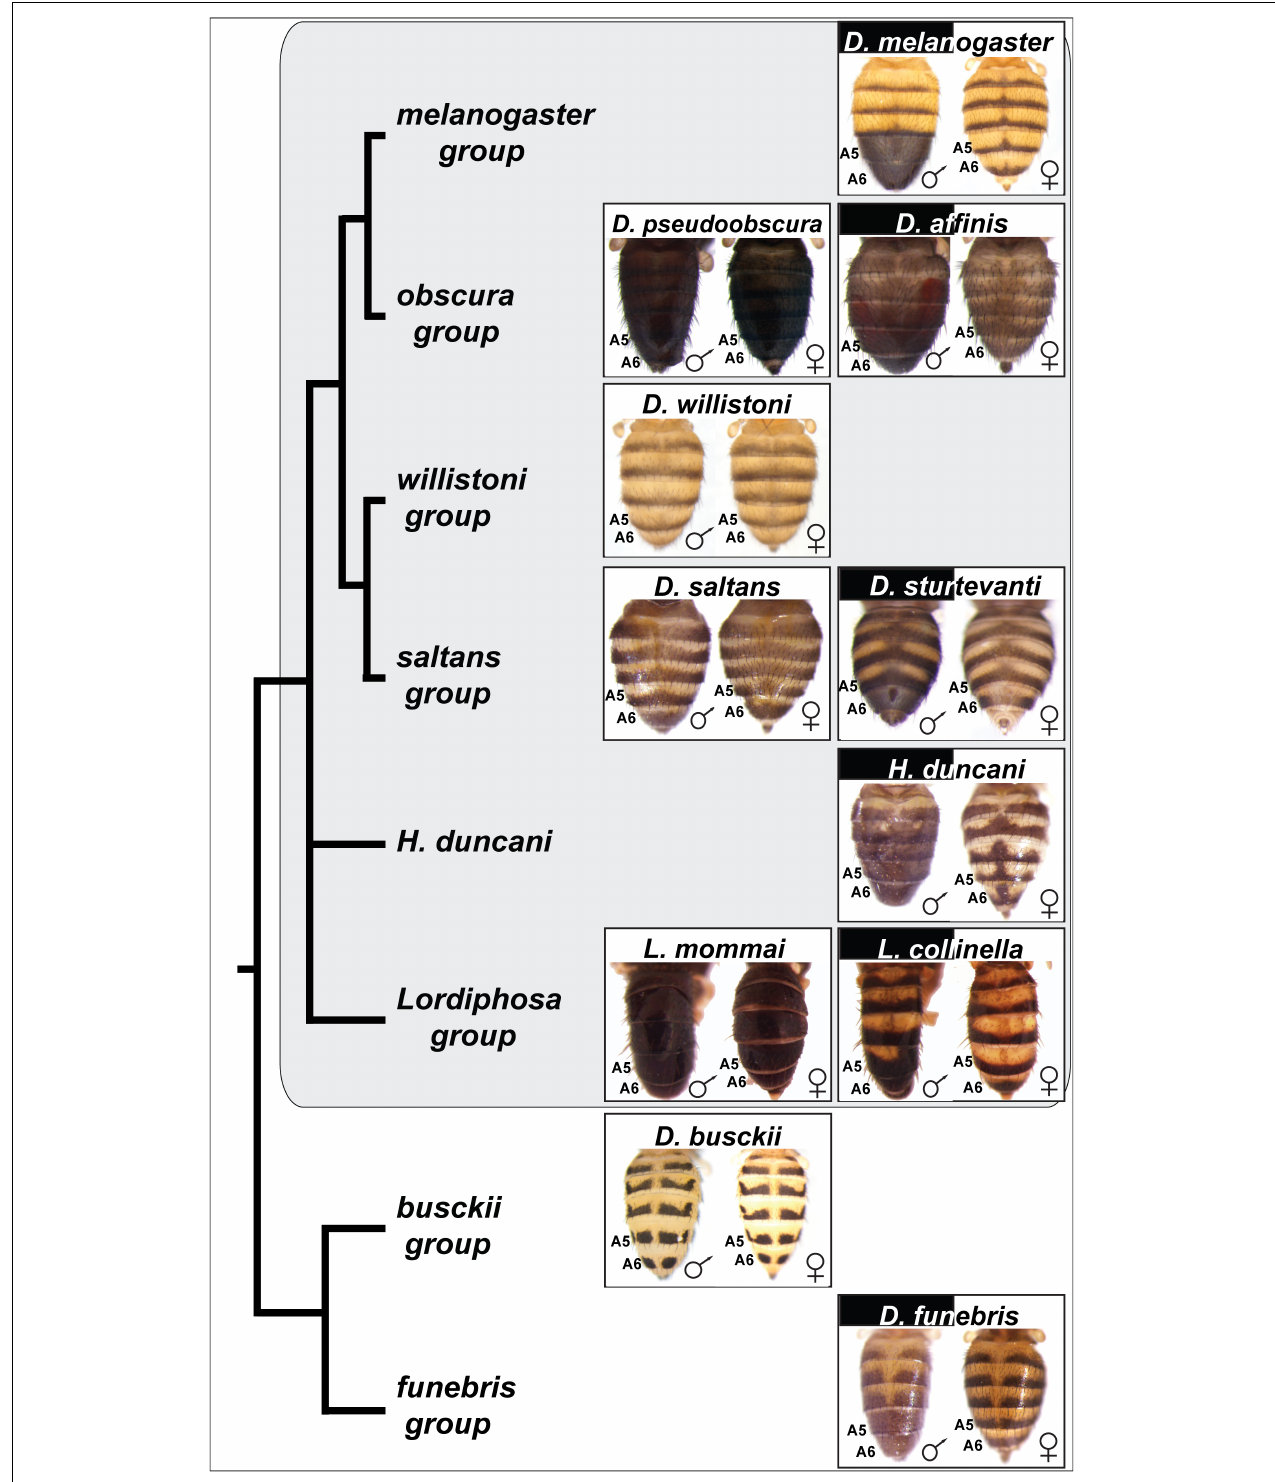
FIGURE 2 | Species with dimorphic tergite pigmentation are widespread throughout the Drosophila genus. Sophophora subgenus species groups and species are indicated by the gray background. D. busckii and D. funebris are included as non- Sophophora species from the Drosophila genus that respectively exhibit monomorphic and dimorphic patterns of tergite pigmentation. The homologous A5 and A6 segment tergites are indicated for each species, the segments bearing the dimorphic pigmentation in D. melanogaster . While the obscura , saltans , and Lordiphosa groups are predominately populated by monomorphic species (e.g., D. pseudoobscura , D. saltans , and L. mommai ), they possess a few dimorphic species, including D. affinis , D. sturtevanti , and L. collinella .